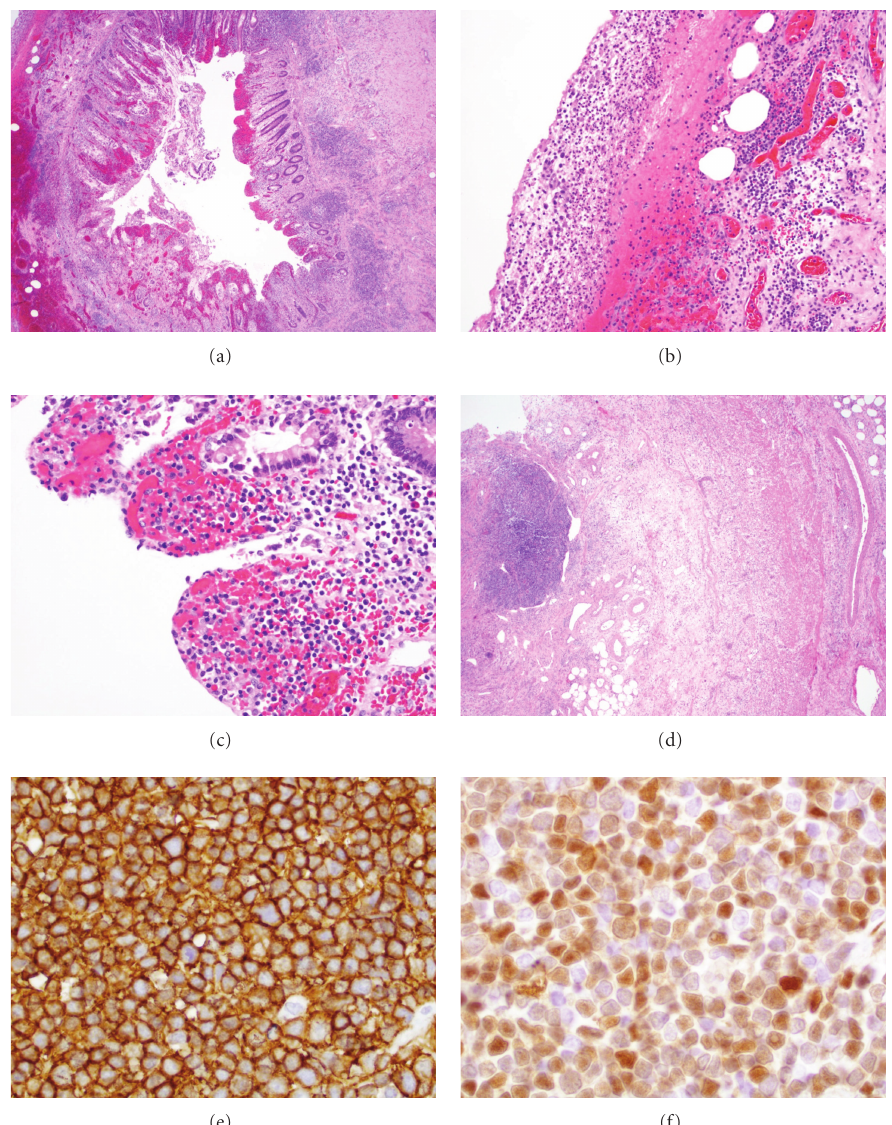
Figure 1: (a) Cross-section of appendix with disrupted mucosal surface and small lymphoid aggregates (hematoxylin and eosin, 2x objectives); (b) serosal surface of appendix with fibrinopurulent adhesions and dilated vessels (hematoxylin and eosin, 10x objective); (c) Inflamed mucosal surface of appendix (hematoxylin and eosin, 20x objective); (d) dense, thickened appendiceal and a lymphoid aggregate (also depicted in (e) and (f)) (hematoxylin and eosin, 2x objective); (e) CD20 immunostain, 50x oil objective; (f) cyclin D1 immunostain, 50x oil objective. All images were captured with an Olympus DP70 camera attached to an Olympus BX45 with a 1x U